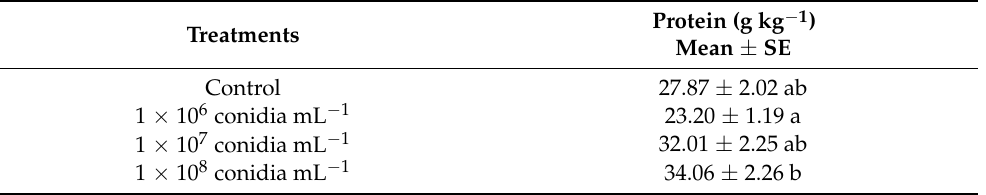
Table 7. Effects of inoculating lettuce plants with different conidial concentrations of Beauveria bassiana on protein contents (g kg − 1 ) ( n = 12).